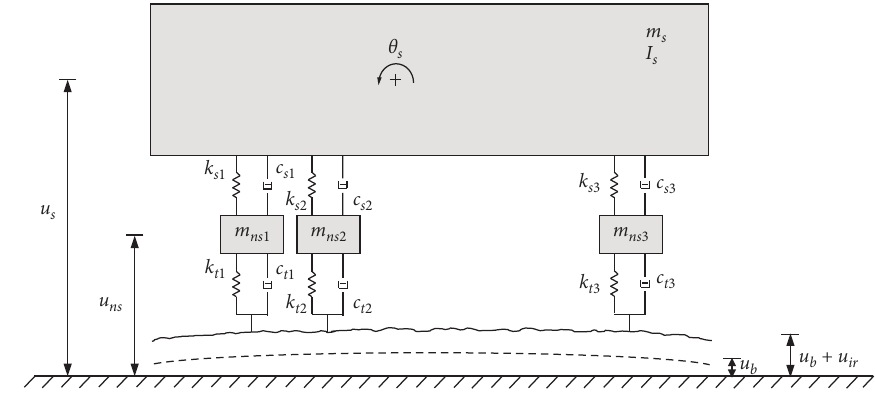
Figure 4: Coupled vehicle-pavement-bridge model.